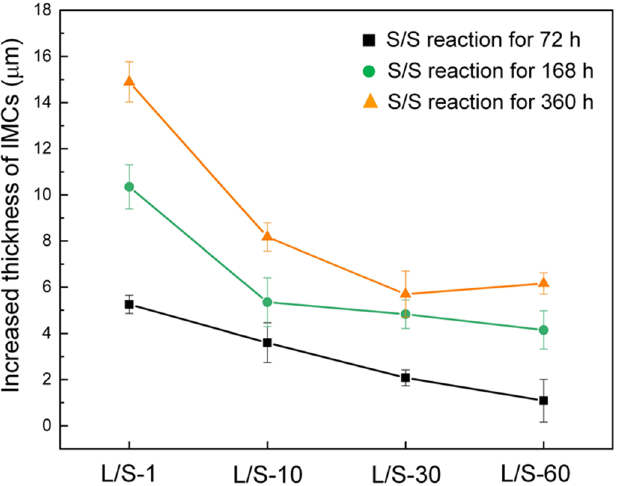
Figure 6. Increased thickness of the IMCs for various L/S reaction samples during the S/S reaction. Table 3. Magnitude of concentration gradient of Cu 6 Sn 5 and Cu 3 Sn for various L/S samples subjected to thermal aging at 200 ◦ C for various lengths of S/S reaction time. (unit: at.%/ µ m).